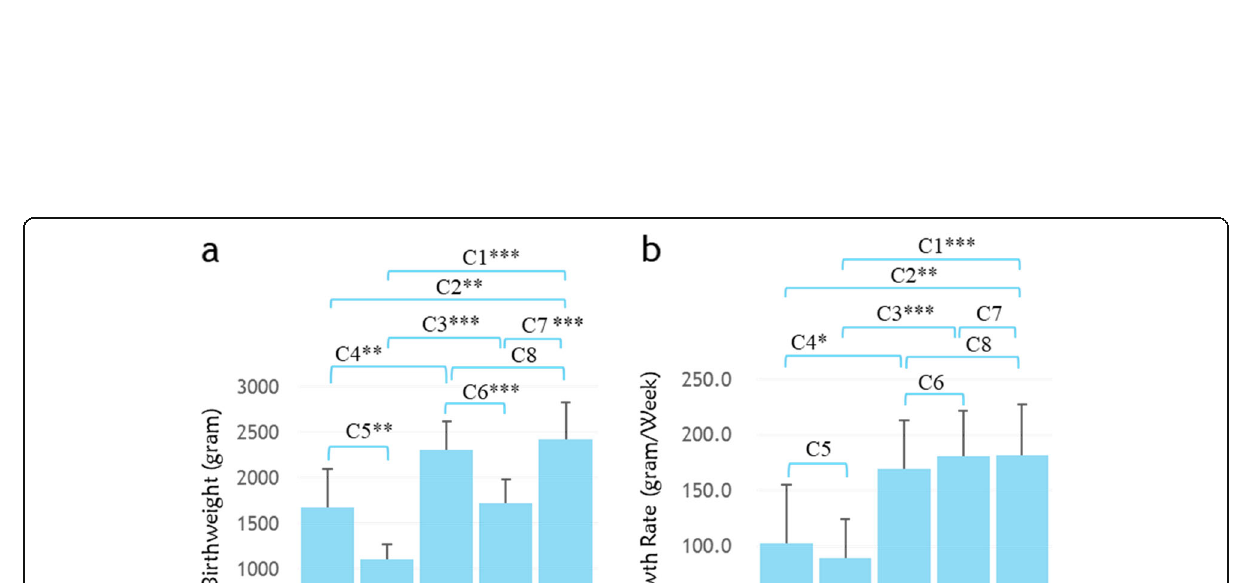
Fig. 2 Schematic diagram of study design. 18 sIUGR MCDA pregnancies and 11 non-complicated MCDA pregnancies were included in this twin study. Among sIUGR pregnancies, 10 twin pairs were diagnosed with normal umbilical artery flow (type 1) and 8 twin pairs were abnormal UAF (types 2&3). Hairs were collected from each twin immediately after delivery for subsequent metabolomic profiling. Comparison 1 compares the metabolic disparity between T2&3 sIUGR-S and Control. Comparison 2 compares T2&3 sIUGR-L and Control. Comparison 3 compares T1 sIUGR-S and T2&3 sIUGR-S. Comparison 4 compares T1 sIUGR-L and T2&3 sIUGR-L. Comparison 5 examines T2&3 sIUGR-L and T2&3 sIUGR-S. Comparison 6 evaluates T1 sIUGR-L and T1 sIUGR-S. Comparison 7 examines T1 sIUGR-S and Control. Comparison 8 compares T1 sIUGR-L and Control. Abbreviations are as follows; sIUGR = Selective intrauterine growth restriction; MCDA = Monochorionic diamniotic; T1 = Normal umbilical artery flow; T2&3 = Abnormal umbilical artery flow; L = Larger twin; S = Smaller